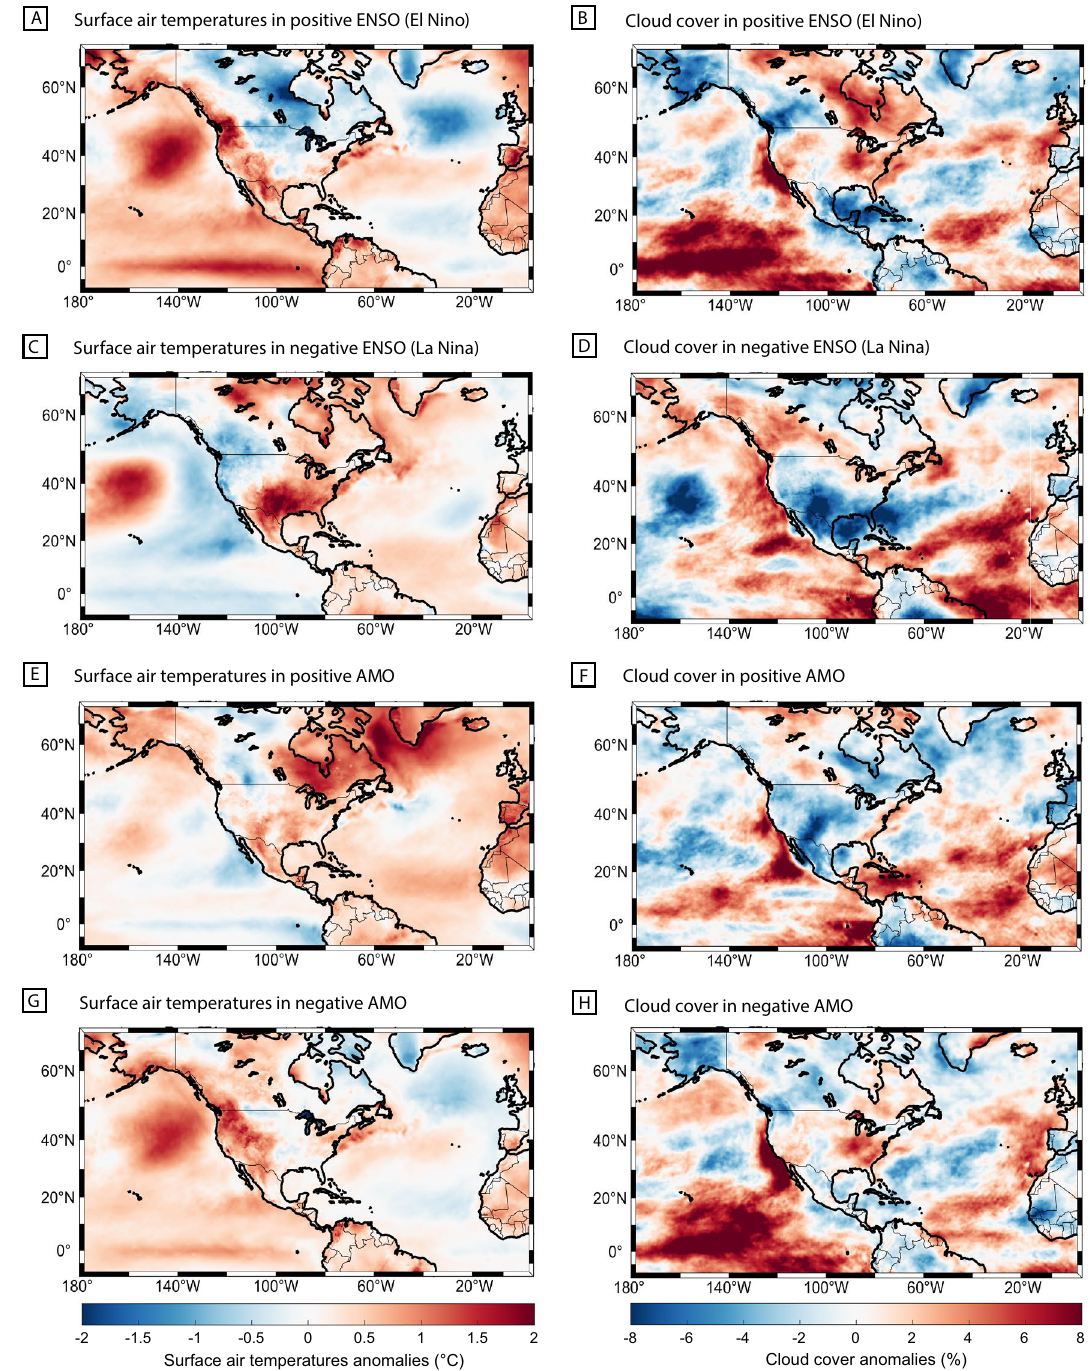
Figure 1. Summer ENSO and AMO Impact on Surface Air Temperatures and Cloud Cover. ( A ) Average summer surface air temperature (°C) and ( B ) cloud cover (%) anomalies during El Niño phases in 2002, 2009, 2015. ( C ) Average summer surface air temperature (°C) and ( D ) cloud cover (%) anomalies during La Niña phases in 2000, 2010, 2011. ( E ) Average summer surface air temperature (°C) and ( F ) cloud cover anomalies (%) during positive AMO phase in 2003, 2005, 2010. ( G ) Average summer surface air temperature (°C) and ( H ) cloud cover anomalies during negative AMO phase in 2002, 2013, 2015. Anomalies are based on the reference period of 1981–2010. The ERA5 dataset was used in MATLAB R2017b (https ://www.mathw orks.com/produ cts/ matla